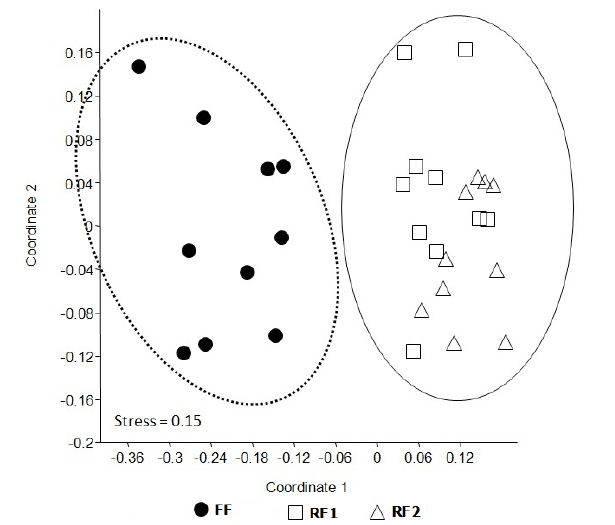
Figure 2. Analysis of non-metric multidimensional scaling ordina- tion (NMDS) from the assemblage composition of ants in three sites of different forest regeneration stages: a fragment of secondary for- est (FF) one area of reforestation with five years (RF2) and other with seven years of reforestation